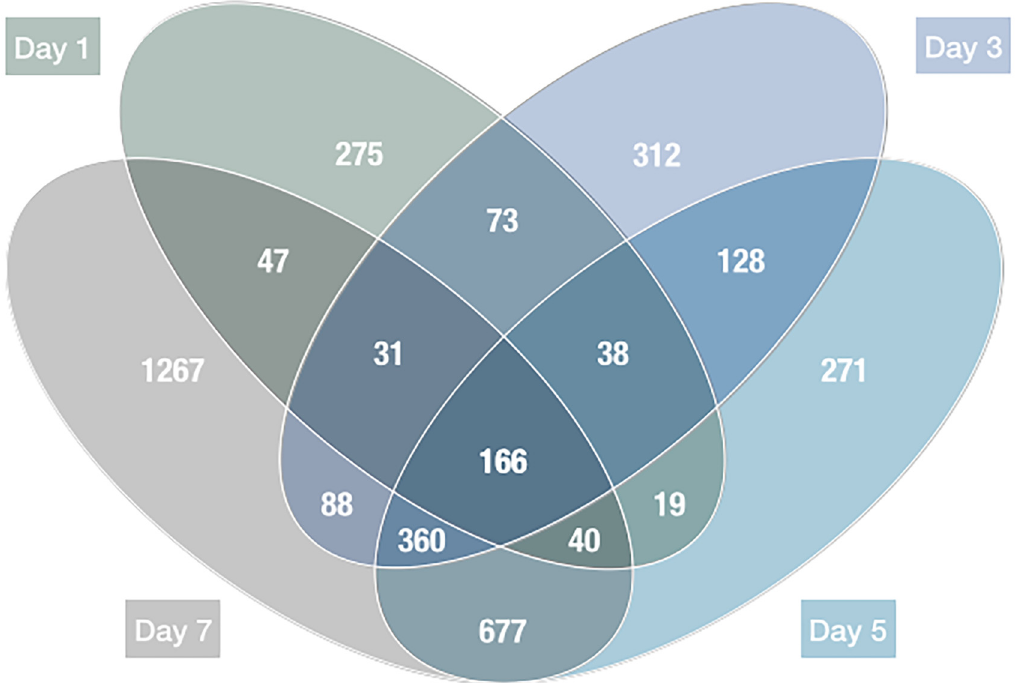
Fig 2. Venn diagram of significantly differentially expressed transcripts over the time course of REV infection. The image displays the number and overlap of differentially expressed transcripts in response to in vitro REV infection at 1, 3, 5, and 7 days post-infection. The numbers of transcripts differentially expressed at more than one time point are shown in the overlapping regions. Additionally, the intersection of the four circles indicates transcripts that were up- or down-regulated at all time points of REV